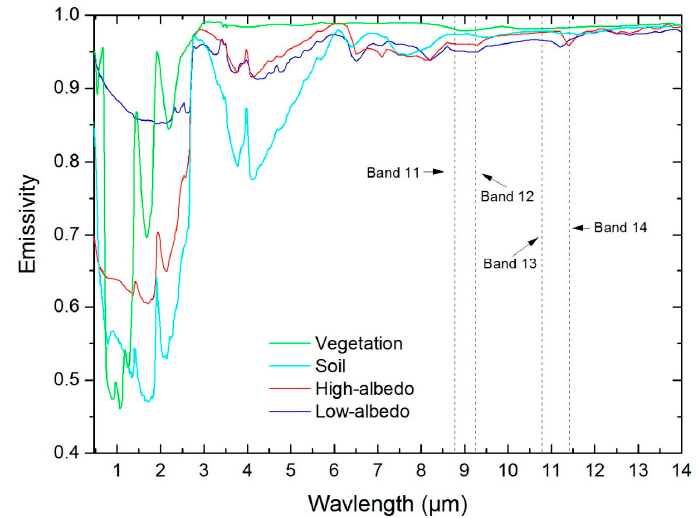
Figure 9. Emissivity spectral curve for each component. These curves were the average of typical urban ground objects listed in the ASTER Spectral Library (Versions 2.0). Table 3. Emissivity for each component at different ASTER thermal infrared bands.